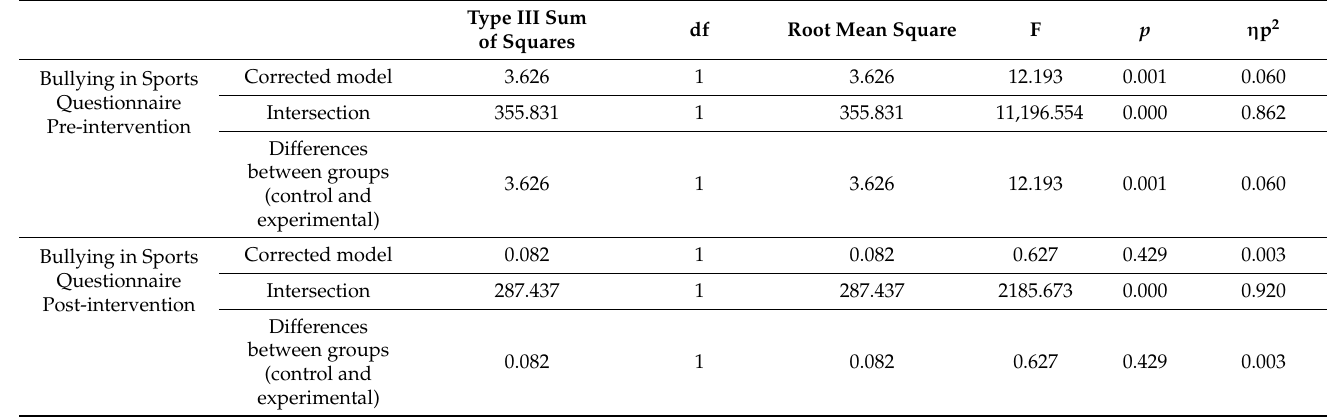
Table 6. Comparison of inter-subject effects for the variable bullying at pre- and post-intervention.